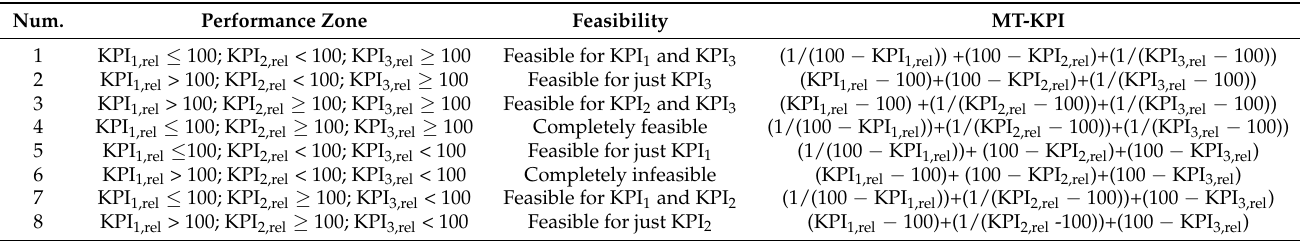
Table 2. Calculation of MT-KPI in different performance